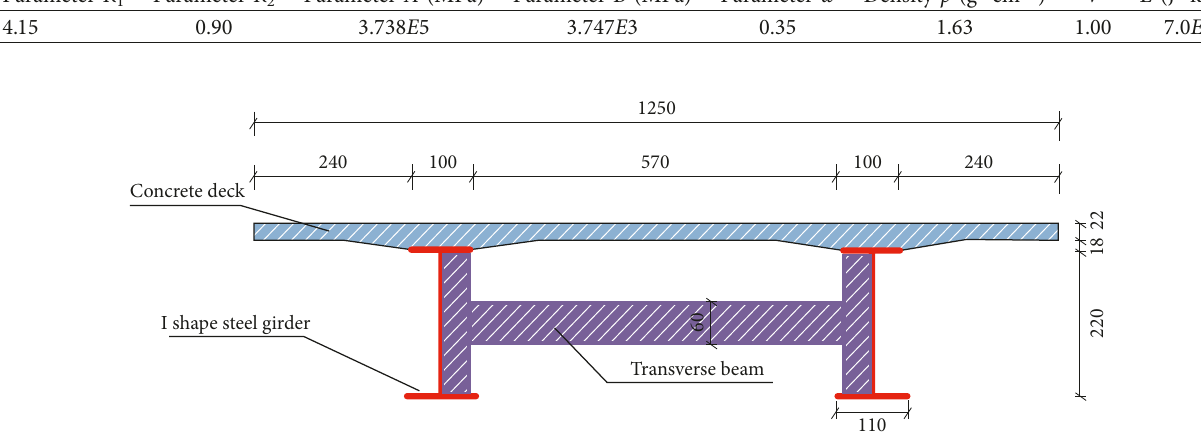
Figure 2: The cross section (unit: cm).